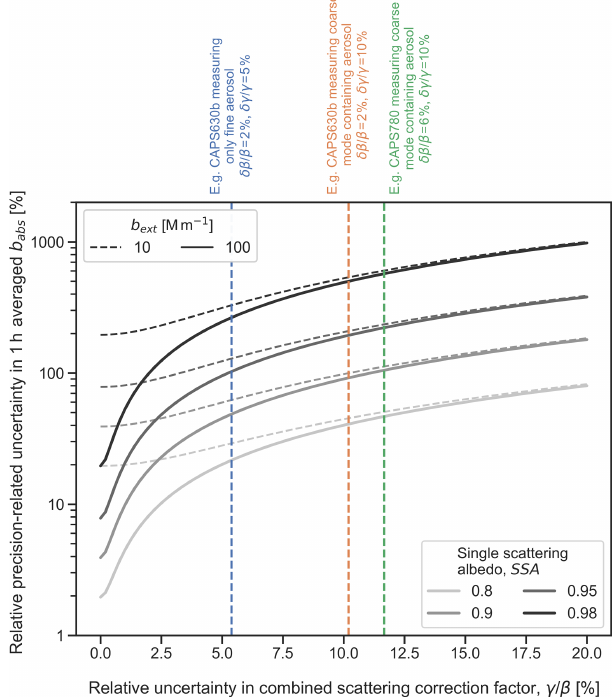
Figure 4. Theoretically calculated relative uncertainty in 1h aver- aged CAPS PMssa b abs measurements as a function of the relative uncertainty in the combined scattering correction factor (defined in Eq. 5 using the ratio of the truncation correction factor γ and the instrument cross-calibration factor β ). Curves are shown for four different SSA values (grey shading) and two different aerosol load- ings ( b ext of 10 and 100Mm − 1 ). The curves were generated using the error model presented in Sect. 2.3 and Appendix B with inputs that were chosen to represent instrument characteristics during the Cabauw field campaign, as detailed in the main